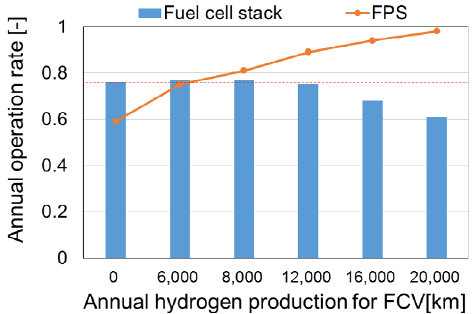
Fig. 5. Analysis of maximum hydrogen supply.